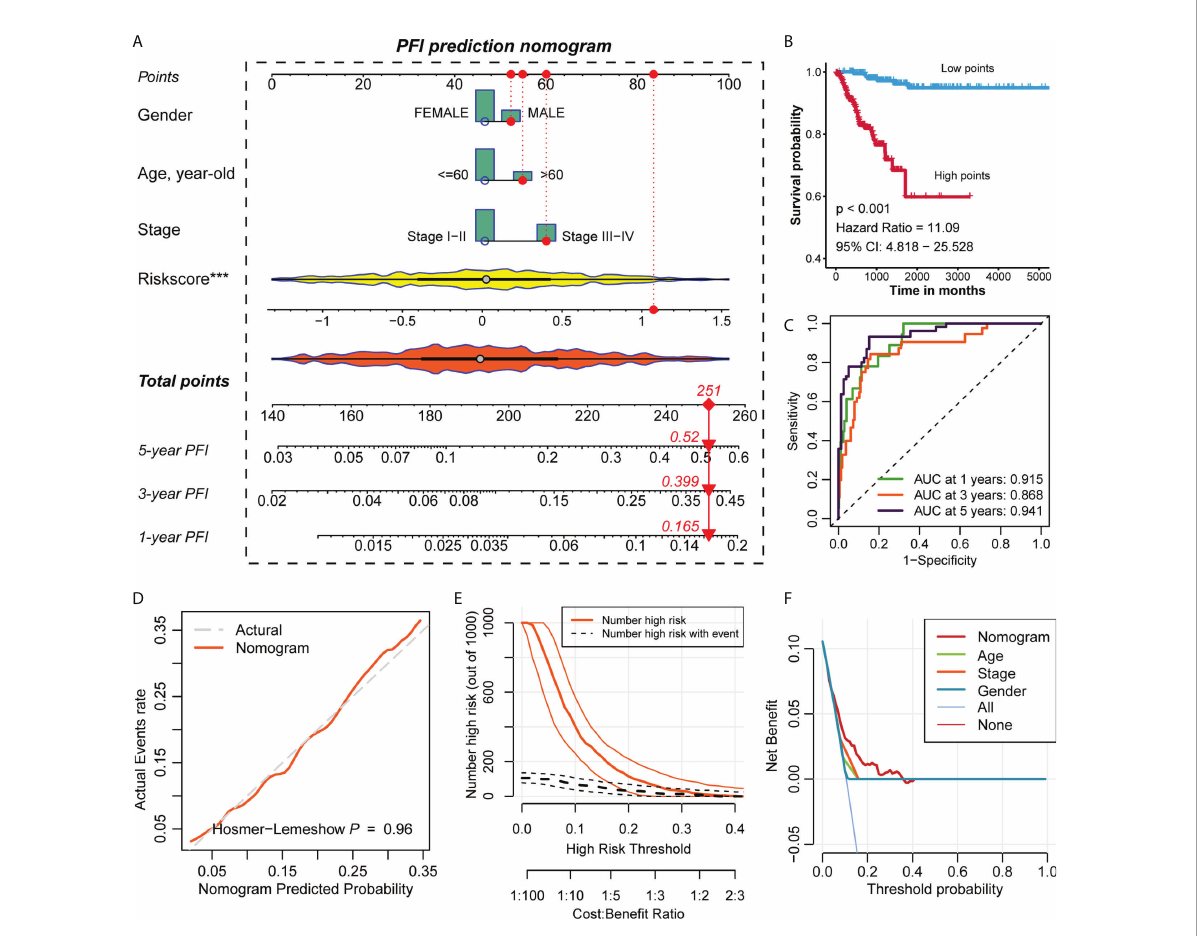
FIGURE 4 Construction of the nomogram and evaluation of prediction accuracy. (A) Construction of the nomogram based on the regplot package for the clinical data of all PTC patients. (B) The Kaplan-Meier survival curve of PFI of the high- and low-points groups in PTC. Statistical signi fi cance of differences was developed by the log-rank test (P < 0.05). (C) Time-dependent ROC analysis predicted the area under the curve of the nomogram for the PFI at 1, 3, and 5 years, respectively. (D) The calibration curves of the nomogram. (E) The clinical impact curves of the nomogram. (F) The decision curve analysis of the